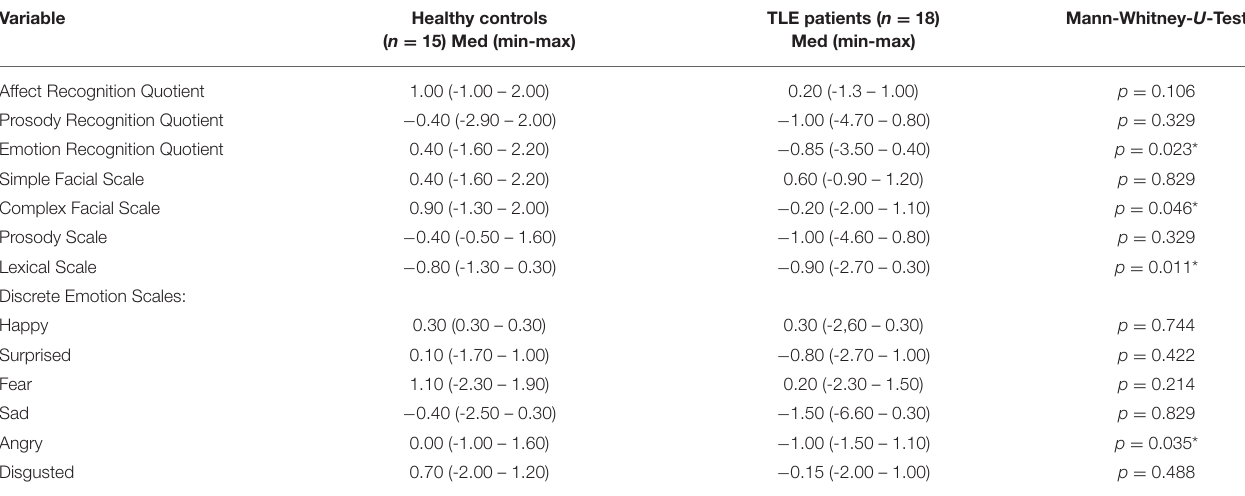
TABLE 4 | Performance of TLE patients and healthy controls on the CATS quotients expressed as Z scores.